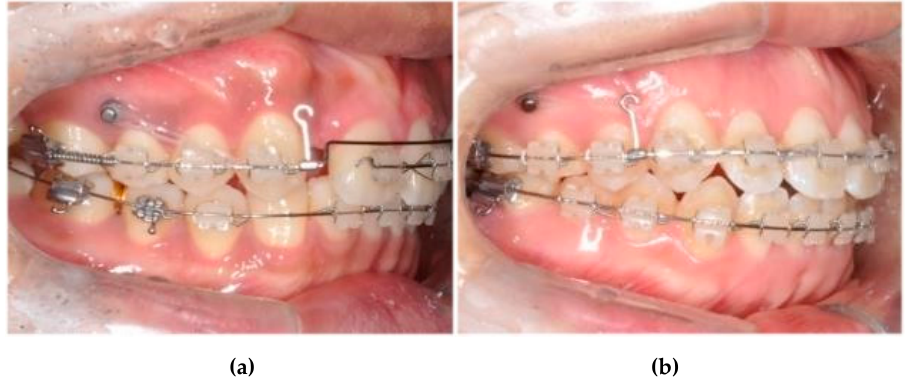
Figure 1. Partial canine retraction ( a ) and en-masse retraction ( b ).